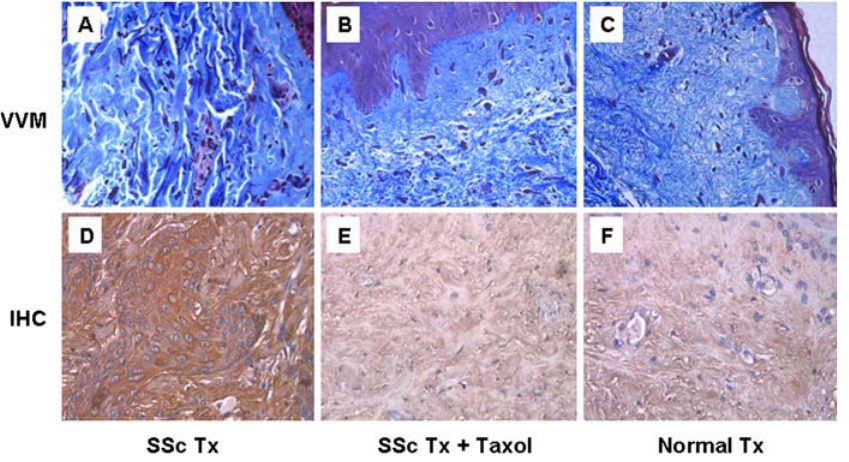
Figure 3. Paclitaxel Decreases Collagen Deposition in SSc Grafts VVM staining shows abundant, thick collagen bundles in the SSc graft (A). The amount of collagen is markedly reduced, and the collagen fibers become finer with paclitaxel (Taxol) treatment (B), comparable to that seen in the normal skin graft (C). Similarly, IHC staining demonstrates intense collagen-1 staining in the SSc graft (D), which is substantially decreased with paclitaxel treatment (E) to a level similar to that seen in the normal skin graft (F). DOI: 10.1371/journal.pmed.0020354.g003 PLoS Medicine |